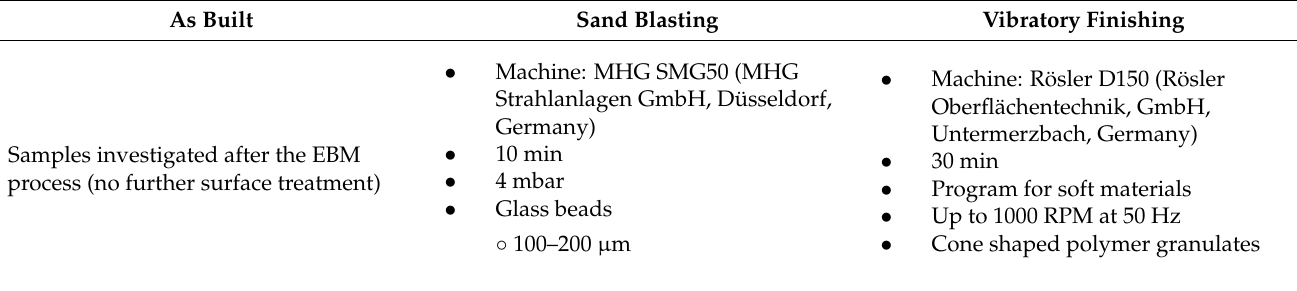
Table 2. Post-processing methods applied in this